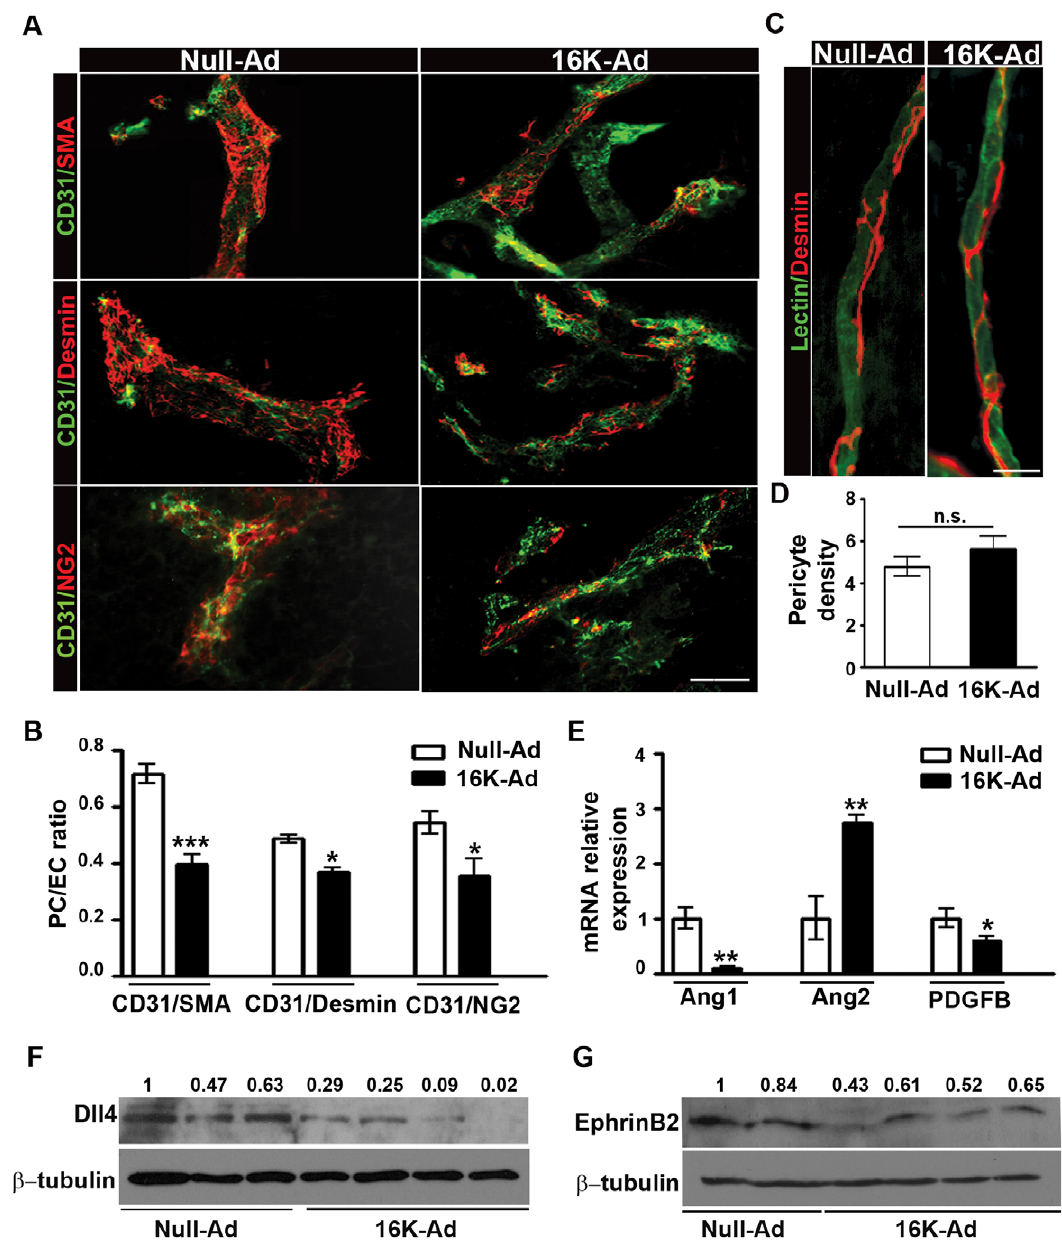
Figure 2. Reduced pericyte coverage in B16F10 tumor vessels after 16K-Ad treatment. (A) Representative photographs of 80 m m thick tumor sections from 16K-Ad- and Null-Ad-inoculated mice, double-stained for the endothelial cell marker CD31 (green) and the mural cell markers a - SMA, desmin, and NG2 (red). (B) Computer-assisted image analysis was used to quantify pericyte coverage. The area occupied by vessels and the covered area were estimated. Coverage was calculated by dividing the latter area by the former. The data represent, for each set of conditions, the mean ratio 6 SEM calculated for all the fields of all tumor sections (one section per tumor). We analyzed 10 tumors of Null-Ad-treated and 8 tumors of 16K-Ad-treated mice. Bar , 100 m m. (C) Representative photographs of tracheal capillaries. Tracheal capillaries from 16K-Ad- and Null-Ad-inoculated mice were visualized by lectin-FITC staining (green) and pericytes were visualized by desmin immunostaining (red). Bar , 25 m m. (D) Computer-assisted image analysis was used to quantify pericyte density. (E) RNAs were extracted from tumors and the relative abundance 6 SEM of each specified mRNA (encoding pdgf-b, Ang1, or Ang2) was assessed by qRT-PCR in 10 Null-Ad tumors and 8 16K-Ad tumors. (F) Western blot analysis of Dll4 and (G) EphrinB2 in different 16K-Ad-treated and control tumors. n.s., non significant. *, P , 0.05. **, P , 0.001. ***, P ,